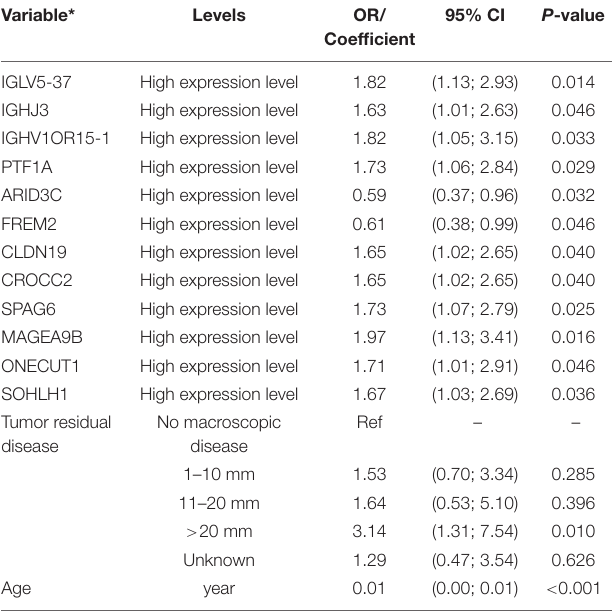
TABLE 2 | Univariate logistic regression showing significant associations with 3-year mortality of OSC.